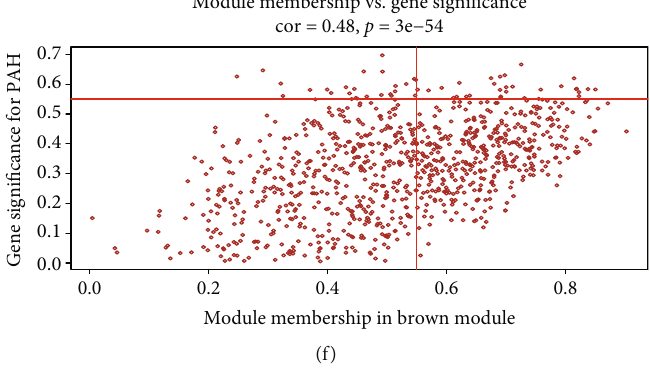
Figure 8: Analysis of the weighted coexpression network in merged dataset. (a) Sample clustering of merged data set. The samples were classi fi ed into two clusters that were signi fi cantly distinct. Cluster 1 was chosen for further analysis. (b) Selection of optimal thresholds. The threshold is 5. (c) The threshold was set to 0.3 and minimum number of genes per module to 50 to merge modules that are similar in the cluster tree. (d) Di ff erent modules are produced and shown in di ff erent colors by aggregating genes with strong correlations into a same module. (e) Analysis of correlations between modules and PAH. The brown module was signi fi cantly correlated with PAH ( r = 0 : 59 ; P = 1e − 11 ) and with normal samples ( r = − 0 : 59 ; P = 1e − 11 ). (f) Correlation plot between MM ( x -axis) and GS ( y -axis) of genes contained in the brown module. PAH: pulmonary arterial